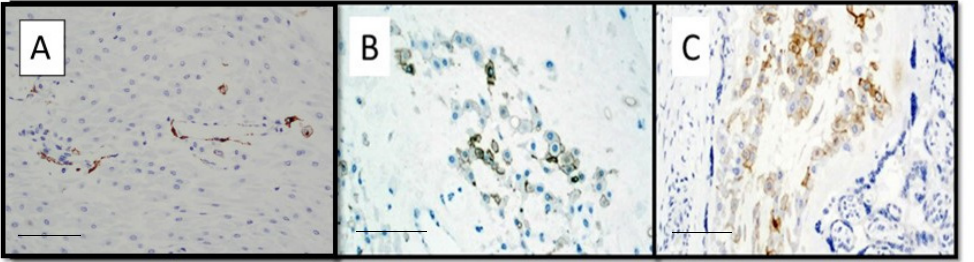
Figure 5. Examples of immunostaining with anti-ACE2 antibody in chorionic discs from the CIC ( A ), CNIC ( B ) and control ( C ) groups (Immunohistochemistry, Original Magnification: 20× ( A – C ). (scale bar: 400 µm).